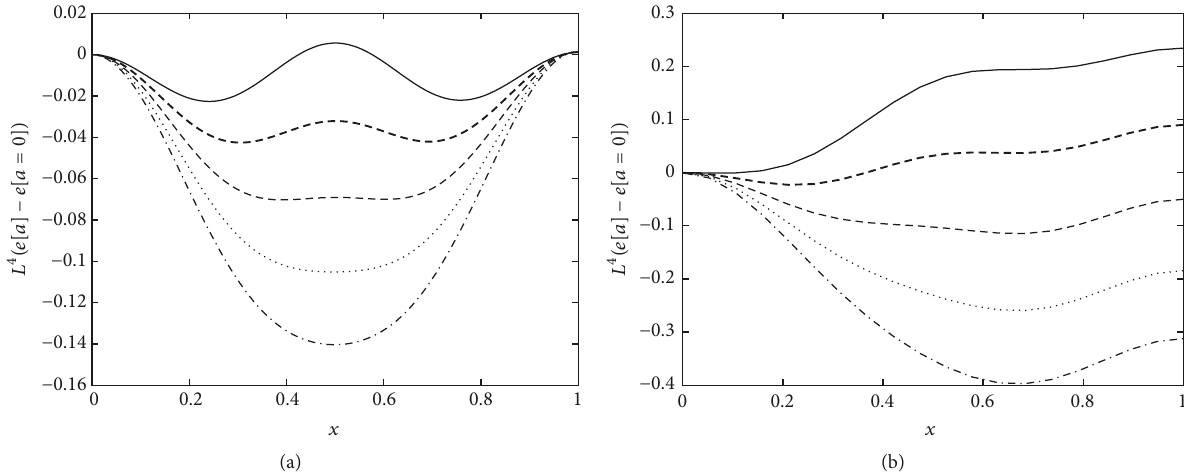
Figure 16: Effective potential of the Polyakov loop (71) as function of the background field 𝑥 = 𝑎 3 𝐿/2𝜋 at various temperatures, for the gauge groups (a) SU (2) and (b) SU (3) .